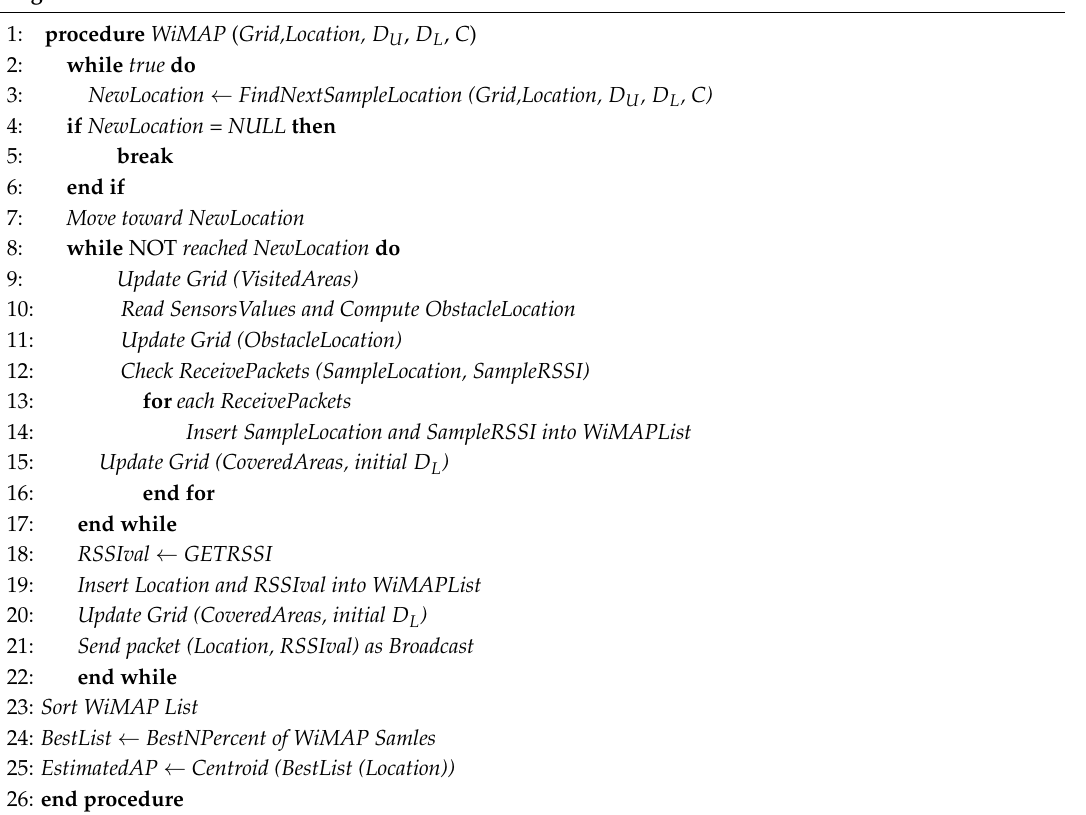
Algorithm 2 Distributed